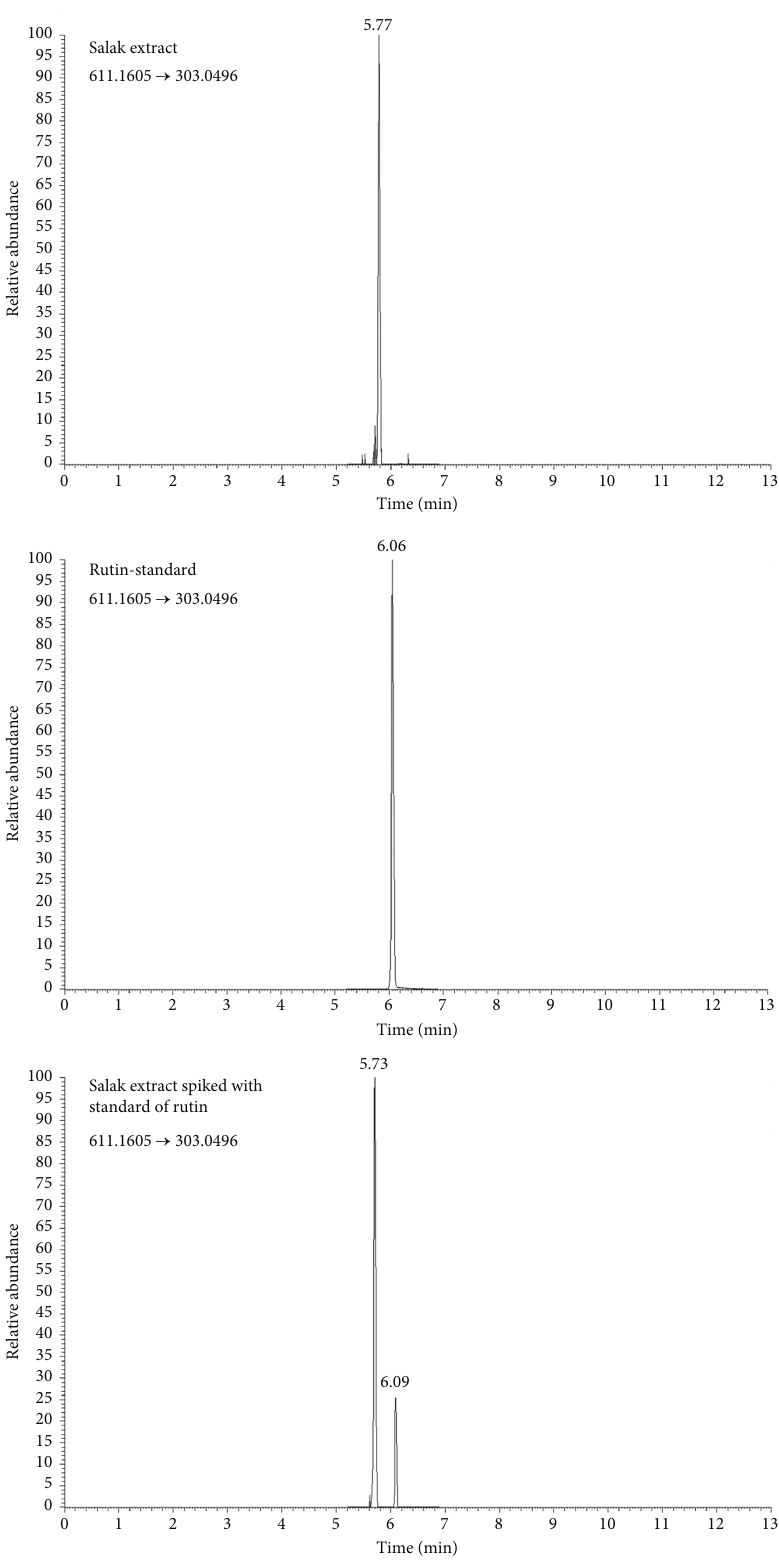
Figure 2: Detection of rutin-like compound (Rt � 5.73 min) in Salacca zalacca fruit pulp and rutin standard (Rt � 6.09min) by UHPLC- HRMS/MS with MS/MS spectrometer operating in PRM (parallel reaction monitoring) mode with positive ionization. PRM transition is described by name of corresponding compound and characterized by its retention time, and m/z values of respective precursor ion and product